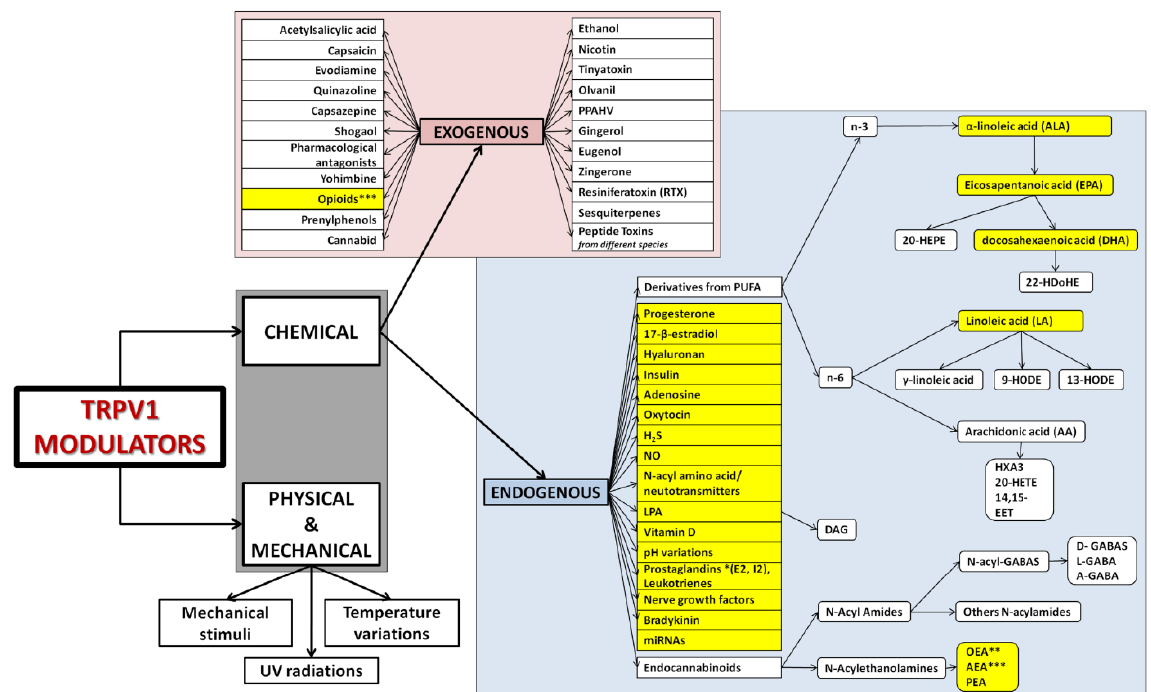
Figure 4. Modulators of TRPV1 function. The schema shows most of the activators and modulators of TRPV1 function investigated to date, divided into two main groups: physical and physical stimuli; and chemical activators. Physical and mechanical modulators include temperature variations (heat or cold) [34], UV radiation [35,36], and mechanical stimuli [37]. The chemical activators group is divided in turn into two subgroups depending on the origin of the activator/modulator: exogenous and endogenous. Exogenous stimuli are capsaicin [38] and its antagonist capsazepine [39], resiniferatoxin (RTX) [37,40], bradykinin [41], yohimbine [42], ethanol [43], evodiamine [44], 17- β -estradiol [45], quinazoline [46], progesterone [47], numerous opioids [48], nicotine [49], hyaluronan [50], insulin [51], tinyatoxin [52], olvanil [53], acetylsalicylic acid [54], eugenol [55], sesquiterpenes [56 – 58], cannabidiol [59], prenylphenols [60], zingerone [61], shogaol [61], PPAHV [62], gingerol [63], numerous pharmacological antagonists [64 – 67], and peptide toxins from different species [4,68]. Endogenous activators comprise numerous compounds [1], such as the wide family derived from polyunsaturated fatty acids (PUFAs). According to the position of the first double bond present in their structures, this big family can be divided into n-3 ( α -linolenic acid (ALA) and its products eicosapentanoic acid (EPA), docosahexaenoic acid (DHA), 20-hydroxyeicosapentaenoic acid (20-HEPE) and 22-hydroxyeicosapentaenoic acid (22-HDoHE)), and n-6 linoleic acid (LA) and its products γ -linoleic acid, arachidonic acid (AA) [69] (which produces hepoxylin, HXA-3, 14,15-epoxyeicosatrienoic acid, 14,15-EET, and 20-hydroxyeicosatetranoic acid, 20-HETE), 9- and 13-hydroxyoctadecadienoic acids (9-HODE and 13-HODE). Other agonists endogenously secreted are oxytocin [70], adenosine [71], nitric oxide [72], hydrogen sulfide (H 2 S) [73], lysophosphatidic acid (LPA) [74] and its derivative diacylglycerol [75], pH variations [76,77], vitamin D [78], N-acyl amino acids/neurotransmitters [79], miRNAs [80,81], prostaglandins, nerve growth factors and the endocannabi- noids family, including N-Acyl amides [82] (N-acyl GABAS [83,84] derived then in D-GABAs, L-GABA and A-GABA) and N-acylethanolamines (NAEs) [85], such as anandamide (AEA) *** [86], oleylethanolamine (OEA) [87] and palmi- toylethanolamine (PEA) [88]. * Product from arachidonic acid. ** Derived also from oleic acid, identified as a TRPV1 natural inhibitor [89]. *** Can be exogenous and endogenous. Compounds evidenced in yellow have been found to produce an effect also in spermatozoa, being synthesized by them or present in the oviductal fluid or female reproductive tract. The two classical and widely studied agonists of TRPV1 are capsaicin and resinifera- toxin (this last considered an ultrapotent agonist) [37], although recent experiments have shown faster and longer-lasting analgesic effects by targeting some new compounds